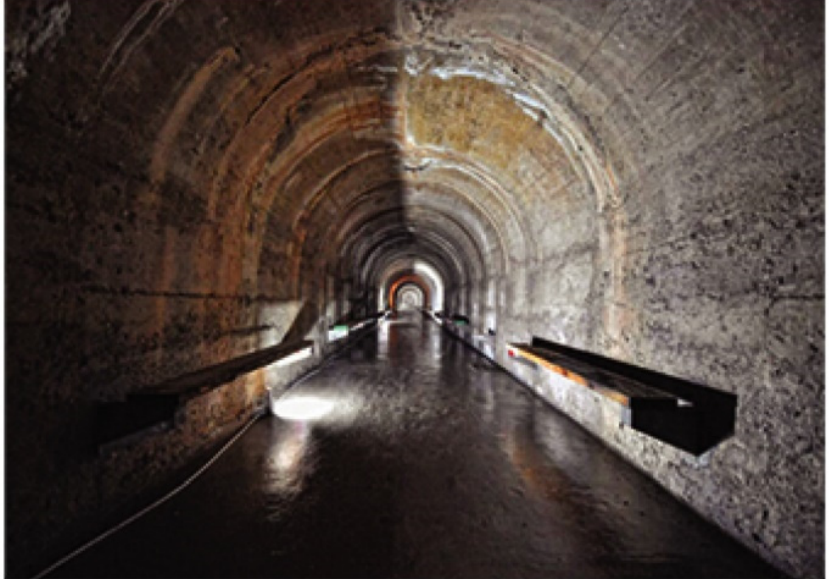
Figure 3. View of the air-raid shelter beneath the Estensi Gardens (http://www.ilvaresotto.it/Citta/